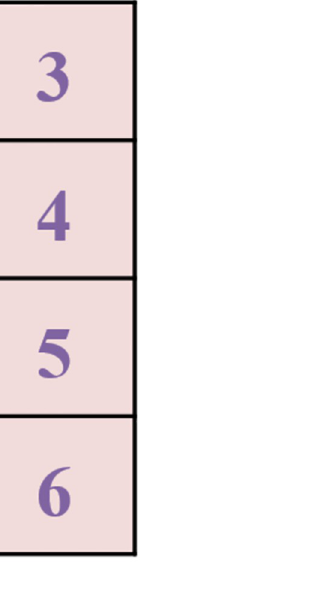
Fig 4. A 4 × 4 data grid for a 11-bit CAN